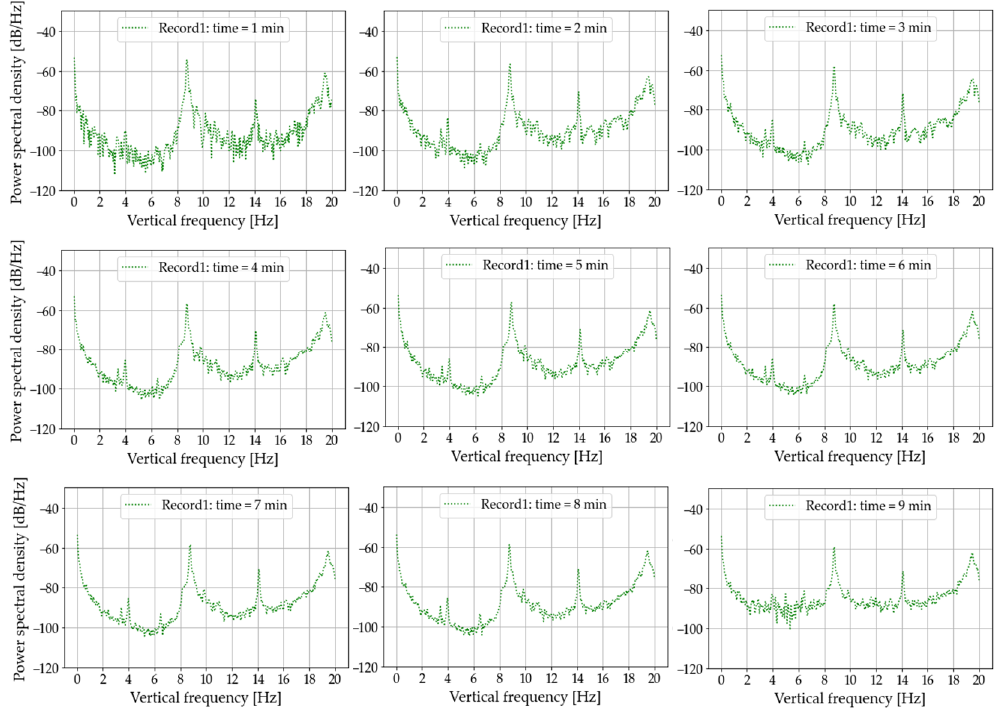
Figure 18. Power spectral density of the first nine vertical frequency observations of the Unilibre bridge.